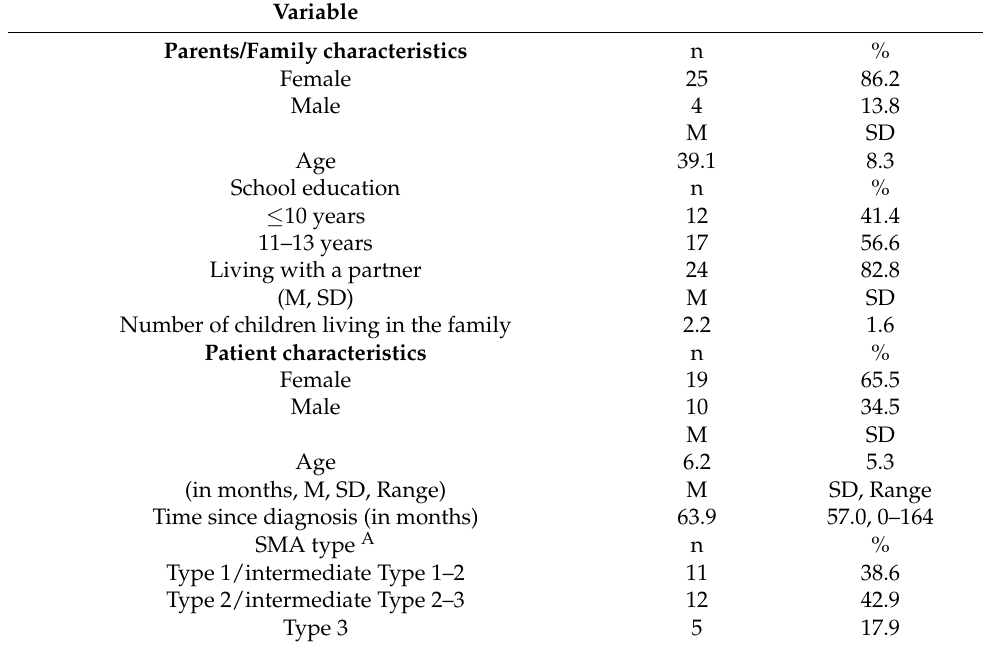
Table 1. Sample characteristics, total n =